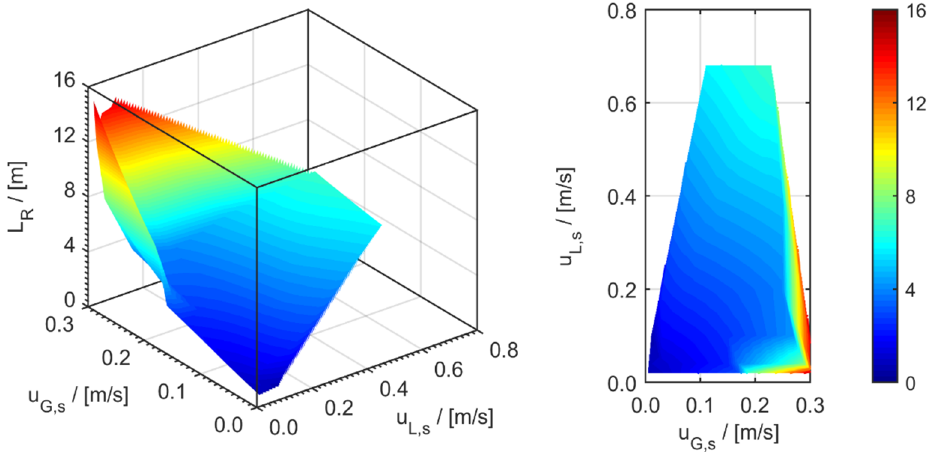
Figure 7. Required reactor length of minichannel wall reactors operating in the Taylor flow mode of different gas and liquid superficial velocities to achieve 99% conversion of the sugars.